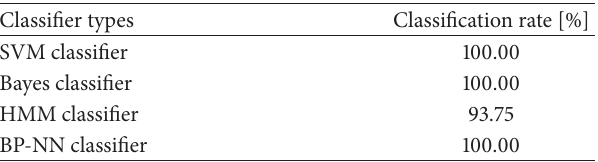
Table 4: Comparison for classification results using different classi-